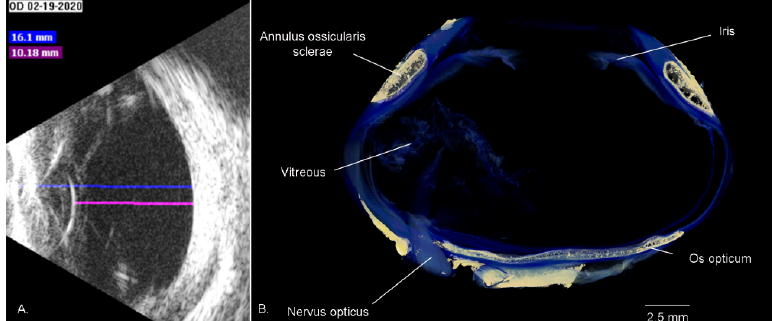
Figure 5. Bulbus oculi (the eye) of selected penguins. ( A ) B ‐ scan ultrasound, little penguin Eudyptula minor eye (Scanmate, DGH Technology Inc., Exton, PA, USA). In this eye, the axial length (blue) measures 16.1 mm and the distance from lens to retina (pink) is 10.18 mm. Credit: PWH; ( B ) Micro ‐ CT of king penguin Aptenodytes patagonicus eye—note the aspheric shape of the eye and the bony elements within (beige). Reconstructed from publicly available raw data at https://figshare.com/ar ‐ ticles/dataset/Hadden_King_penguin_micro_CT_stained_eye/12924741 accessed on 23 August 2022(Digital Science, London, UK) using CT Vox 3.3 (Bruker MicroCT, Kontich, Belgium) software. Suburo and Scolaro [44] described the anterior segment of the Magellanic penguin eye, noting that the shape of the anterior portion of the eye resembles a cone truncated by the cornea and is somewhat less spherical than the posterior half of the globe. The ocular dimensions of several different species have been measured [34,36,47]. Bliss et al. [48] found a mean axial length of 20.34 ± 0.79 mm (anterior cornea to retina) in the macaroni penguin using a 7 MHz B scan probe. The distance from the corneal surface to the anterior pole of the lens was 2.81 ± 0.58 mm, the axial lens thickness was 4.93 ± 0.67 mm, and the posterior lens to retina distance was 12.54 ± 0.50 mm. Males had larger eyes and larger anterior chambers than females. The same authors also examined southern rockhopper penguins Eudyptes chrysocome , finding an axial length of 17.91 ± 1.99 mm. The corneal sur ‐